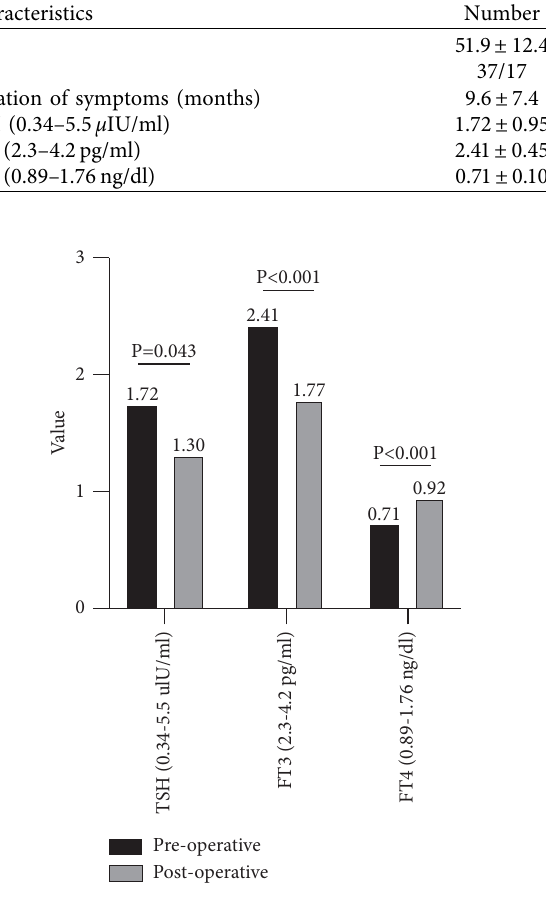
Figure 1: Te preoperative and postoperative thyroid function results of the 54 NFPA patients combined with CH.